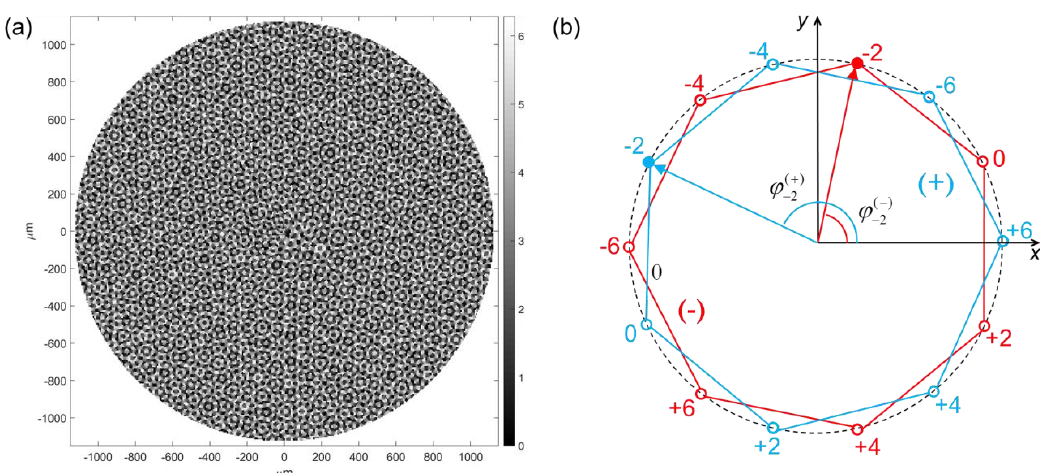
Figure 3. ( a ) Numerical phase pattern for the demultiplexing of optical beams with OAM in the set { − 6, − 4, − 2, 0, + 2, + 4, + 6} on a heptagonal configuration. Pixel size: 6.250 µ m × 6.250 µ m. 16 phase levels. Radius length: 180 pixels. ( b ) Far-field channel scheme for the given OAM set and circular polarization states. Right-handed (in blue) and left-handed (in red) circularly-polarized OAM beams are detected in far field on two distinct heptagons.